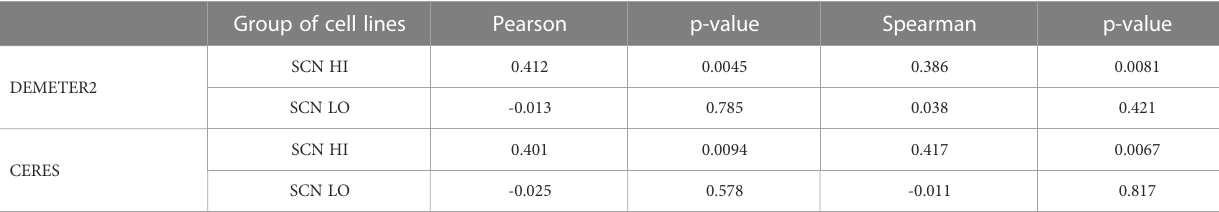
TABLE 1 Correlation analysis of DEMETER2 and CERES in SCN HI and LO group of cell lines. Group of cell